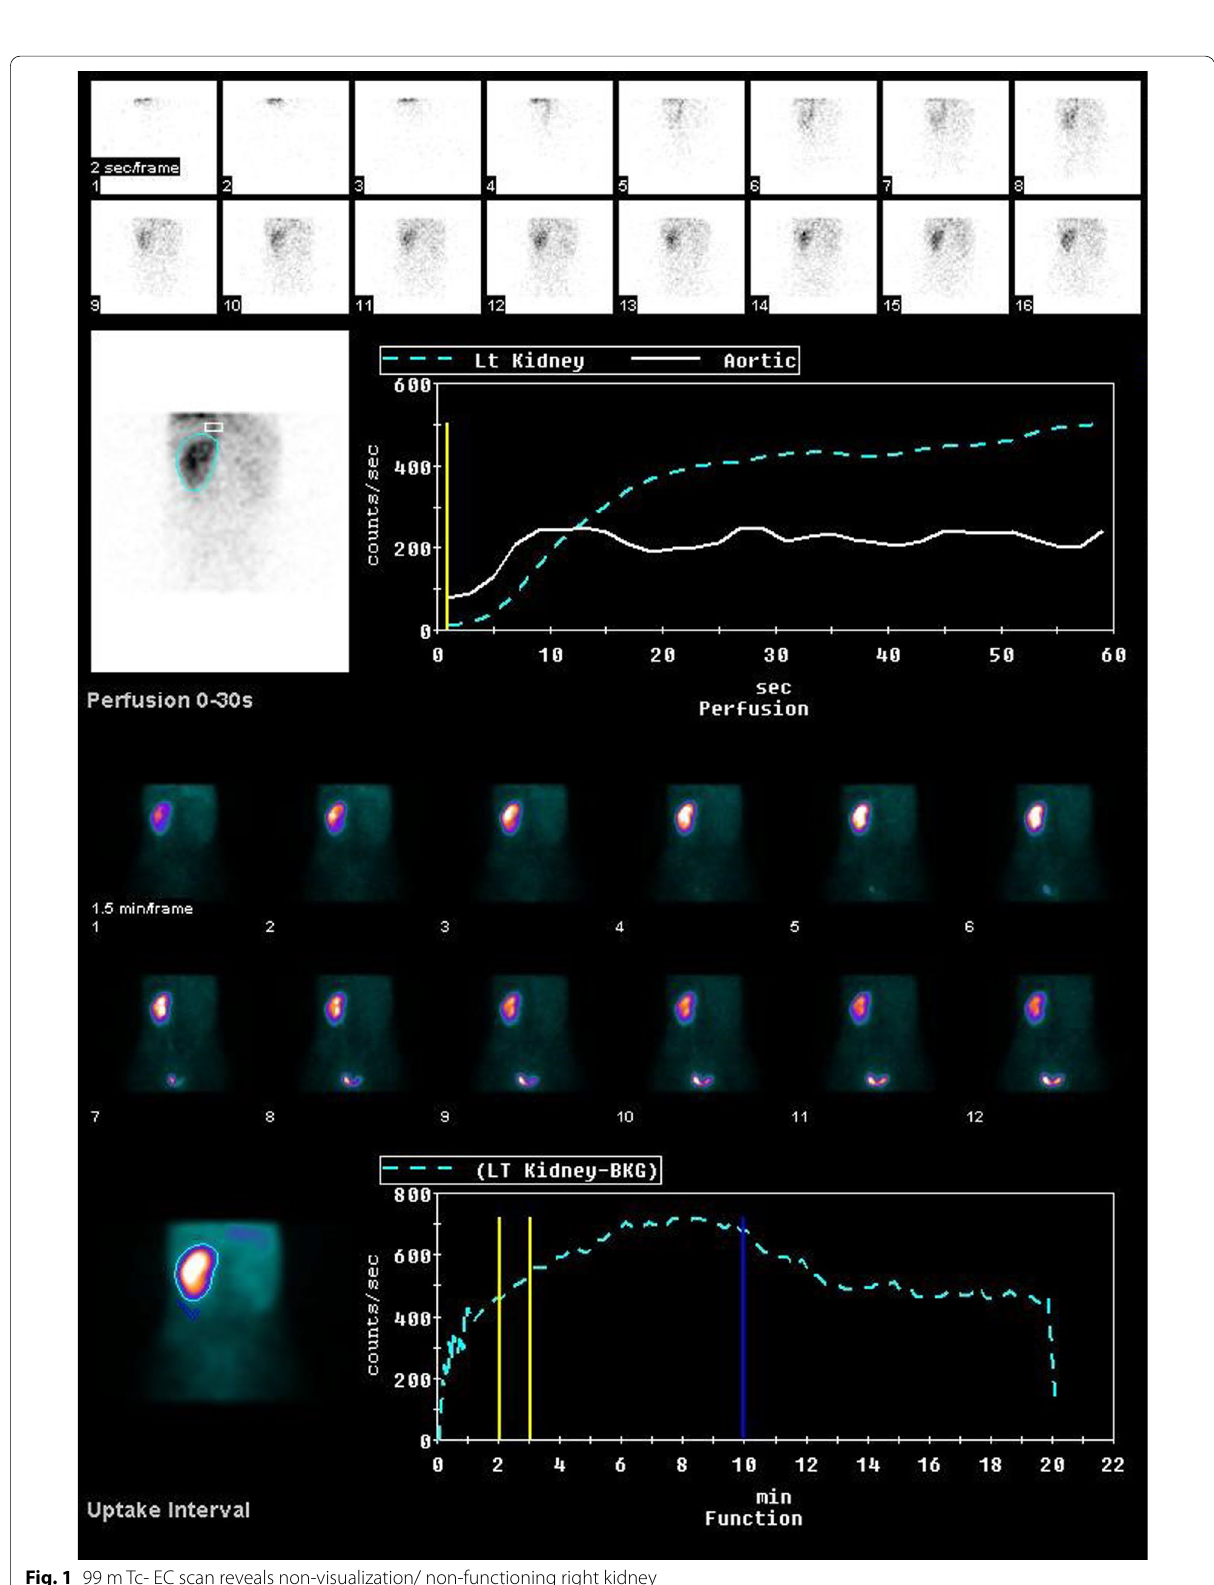
Fig. 1 99 m Tc- EC scan reveals non-visualization/ non-functioning right